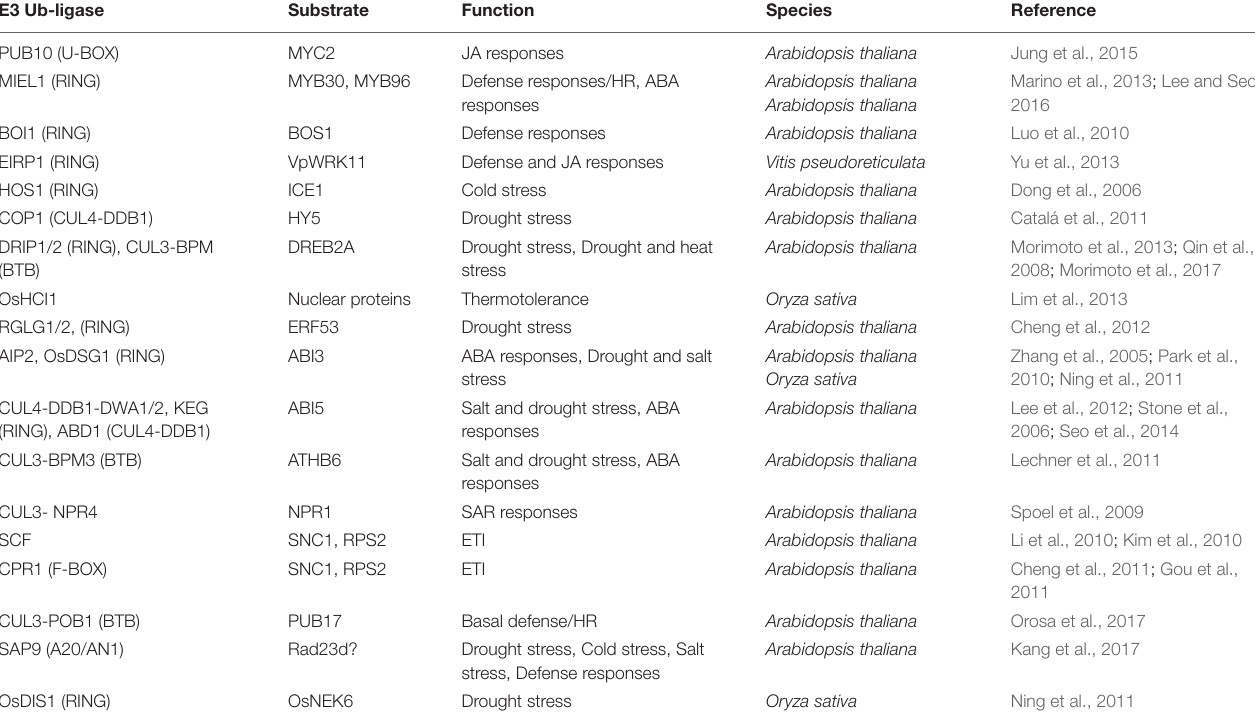
TABLE 1 | Plant E3-Ub ligases with known nuclear targets and their